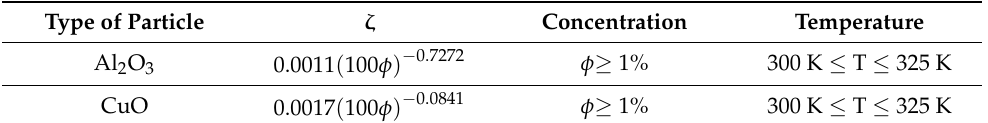
Table 1. Empirical constants for different types of nanoparticles at φ ≥ 1% and a temperature range of 300 K ≤ T ≤ 325